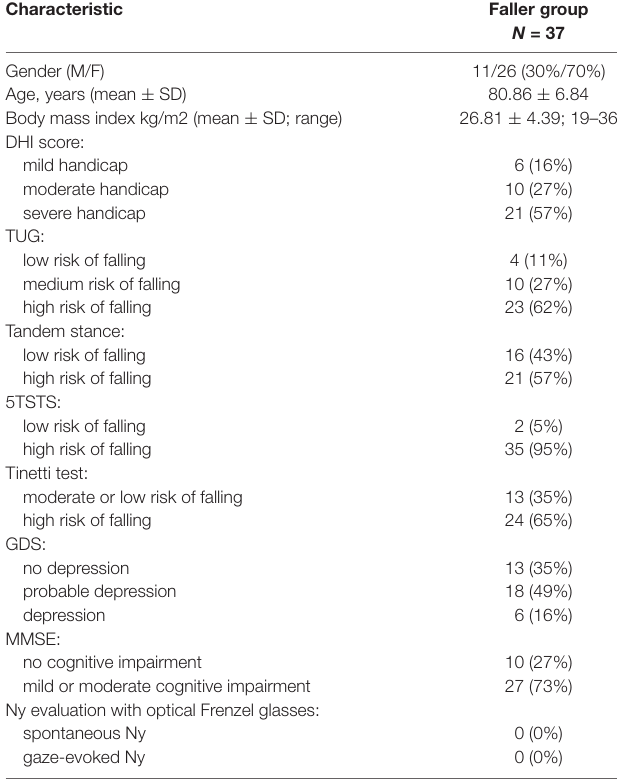
TABLE 2 | Demographical and clinical data of the faller